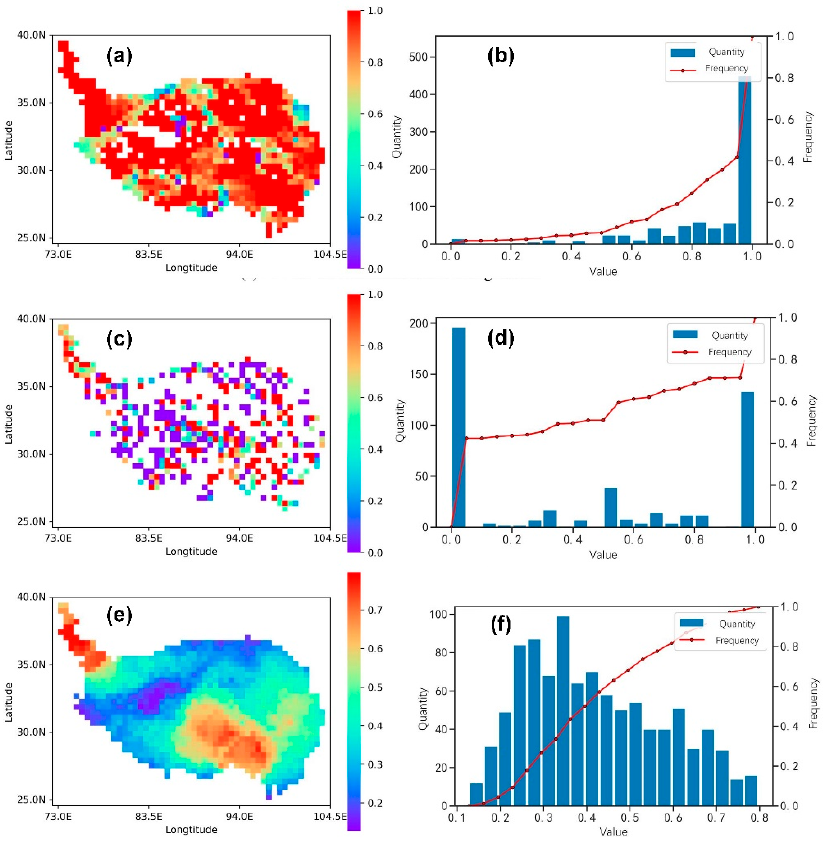
Figure 16. The results for the best spatially variable parameters of the testing dataset: ( a , b ) the PPV of the optimal model in each subregion and the distribution histogram of the PPV, respectively; ( c , d ) the